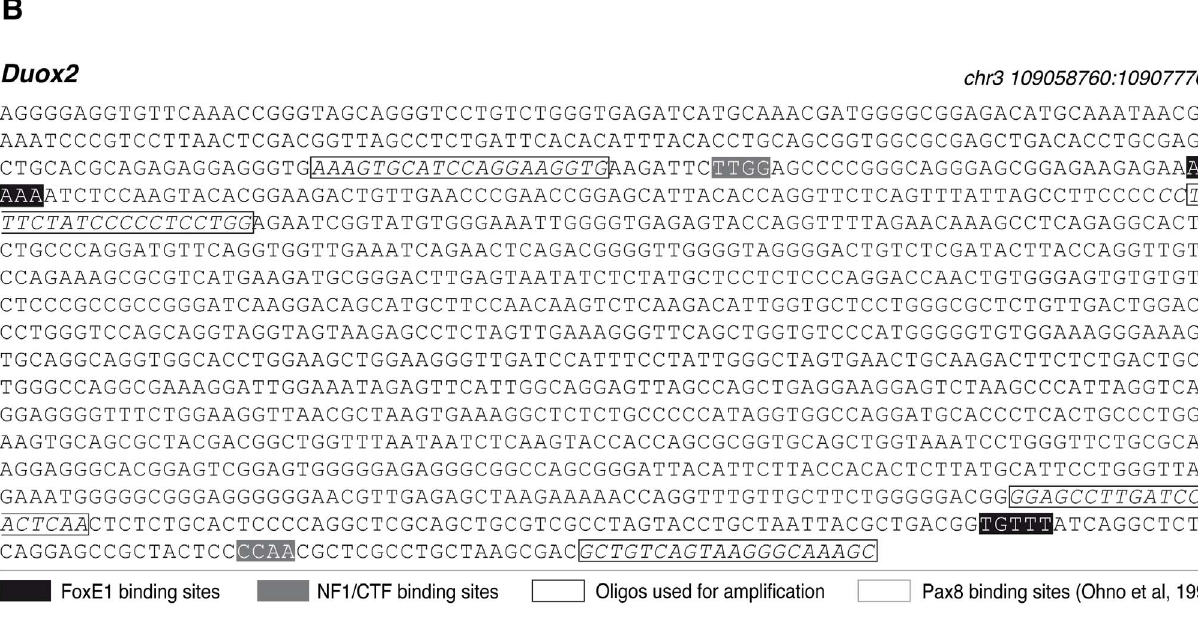
Figure 3. Putative FoxE1-NF1/CTF binding sites in the Duox2 gene and in the NUE. Chromosomal location of putative FoxE1 and NF1/CTF binding motifs in the Nis upstream enhancer (panel A) and the Duox2 gene (panel B). Oligos used and exons are represented in italics.